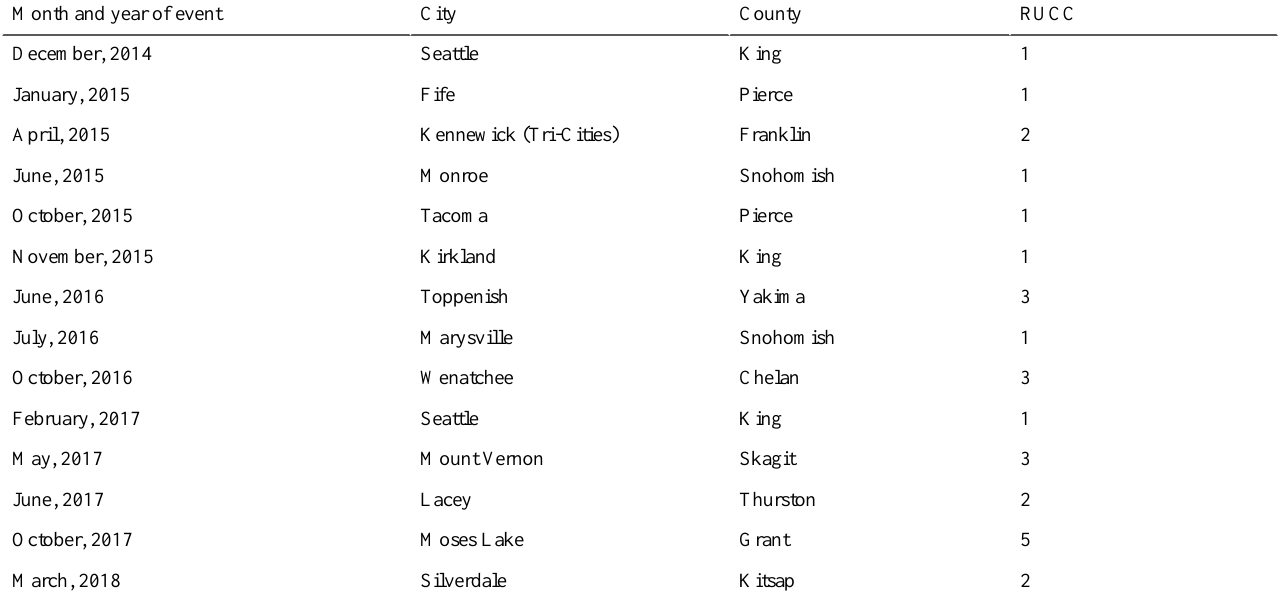
Table 1. Locations and times of events that were evaluated along with their rural and urban codes (RUCC). RUCCCountyCityMonth and year of